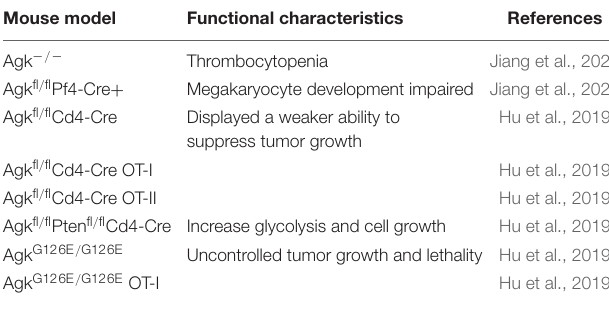
TABLE 4 | The summary of AGK mouse